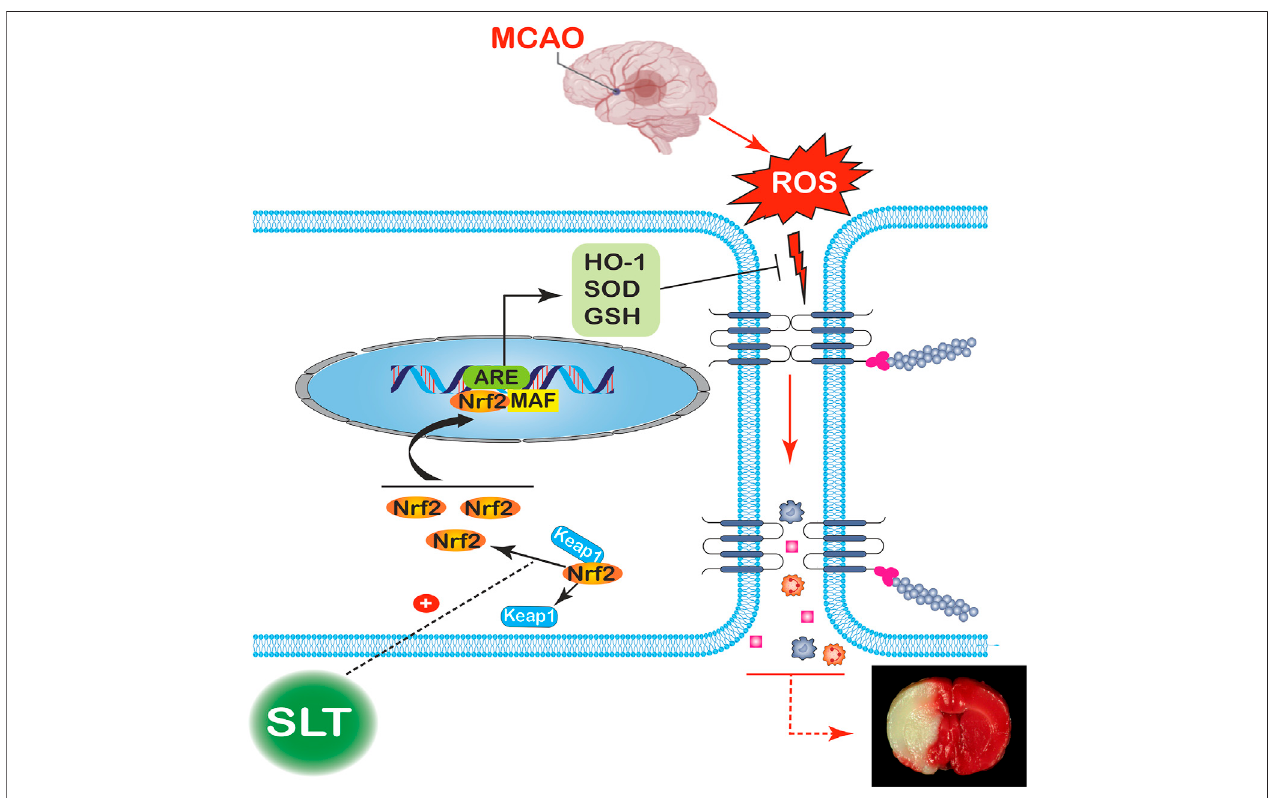
FIGURE 9 | Putative mechanism for the therapeutic effect of SLT on brain ischemia. Occlusions in the cerebral arteries induce a drastic elevation in ROS contents; the excess ROS severely disrupts the brain blood barriers, leading to serious leakages from the blood vessels and brain edema, fi nally resulting in an infarction of large volume.SLTdramaticallyreleasesNrf2detainedinthecytoplasmandpromotesitsnucleustranslocation,thusprimingthedownstreamtranscriptionsandincreasingthe contents of HO-1, SOD, and GSH, which then lead to massive elimination of ROS, cutting off the injury cascade and fi nally rescuing the brain from